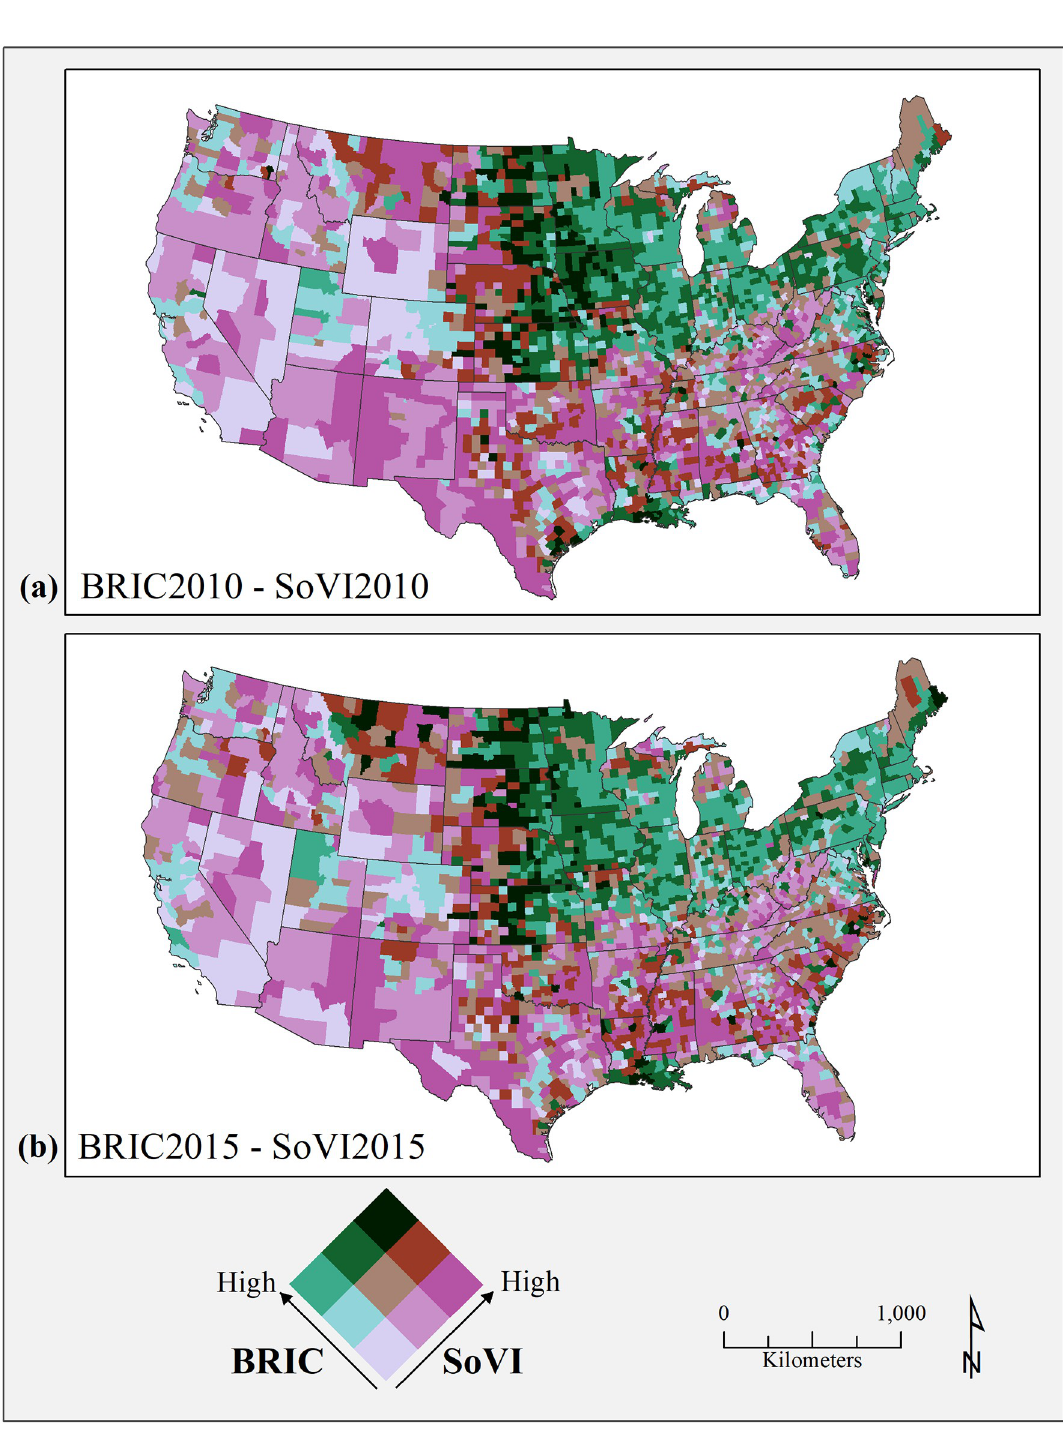
Fig 1. Bivariate maps for BRIC and SoVI (a) 2010 and (b) 2015. County and state boundaries are retrieved from the U.S. Census Bureau (https://www.census.gov/geographies/mapping-files/time-series/geo/carto-boundary-file.html).